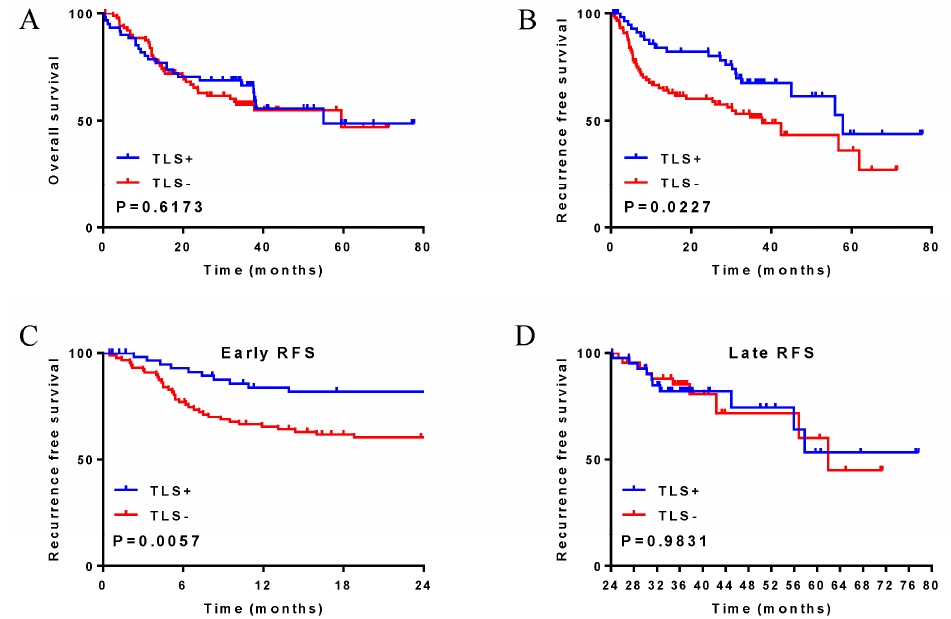
Figure 2. Xijing Hospital data, effects of TLSs on overall survival and recurrence-free survival in patients with hepatocellular carcinoma. ( A ) overall survival; ( B ) recurrence-free survival; ( C ) early recurrence-free survival; ( D ) late recurrence-free survival. Table 2. Univariate and multivariate Cox regression analyses of risk factors associated with recur- rence-free survival from the Xijing Hospital data (HCC patients did not receive any other anti-tu- mour therapy prior to tumour resection).